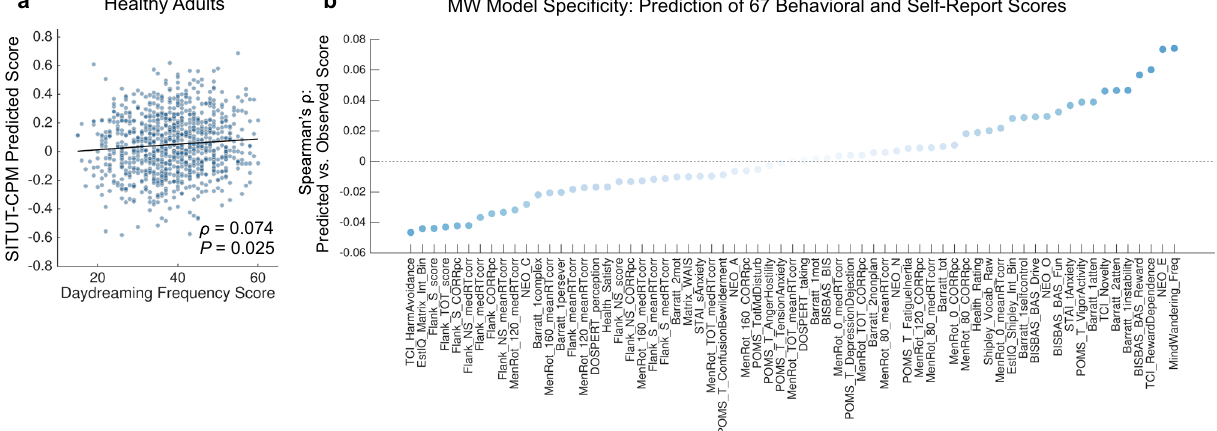
Fig. 4 SITUT-CPM predictions from resting-state fMRI correlate with individual differences in daydreaming frequency scale scores (Superstruct dataset). a Signi fi cant positive correlation between SITUT-CPM-predicted versus observed scores on the daydreaming frequency scale within the Superstruct rs-fMRI dataset. The trend line (for visualization purposes) is based on locally weighted regression fi tting with a second-order polynomial. Statistical testing was performed based on Spearman ’ s rank correlation (coef fi cient and two-sided p value shown). Source data are provided as a Source data fi le. b Correlations (ordered by rank) between SITUT-CPM prediction and 67 behavioral and self-report outcomes in the Superstruct dataset. Among all outcomes, daydreaming frequency (denoted as “ MindWandering_Freq ” ) showed the highest correlation with model prediction. Light to dark blue scale indicates lower to higher absolute correlation value. See ref. 68 for a phenotype legend of labels shown. SITUT stimulus-independent, task-unrelated thought, CPM connectome-based predictive